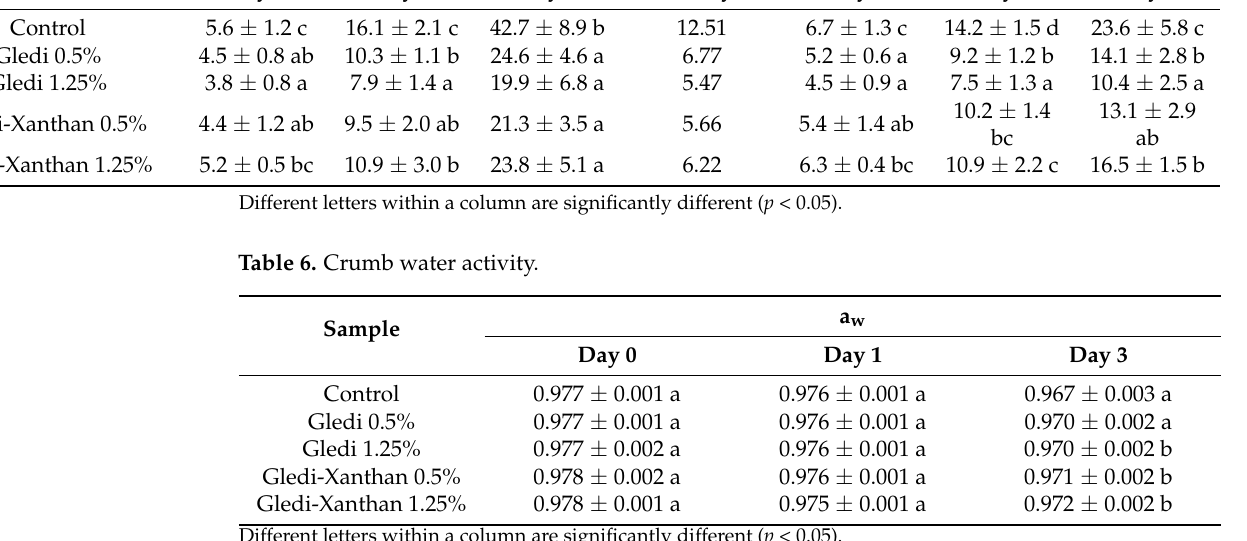
Table 5. Gluten-free bread textural parameters.